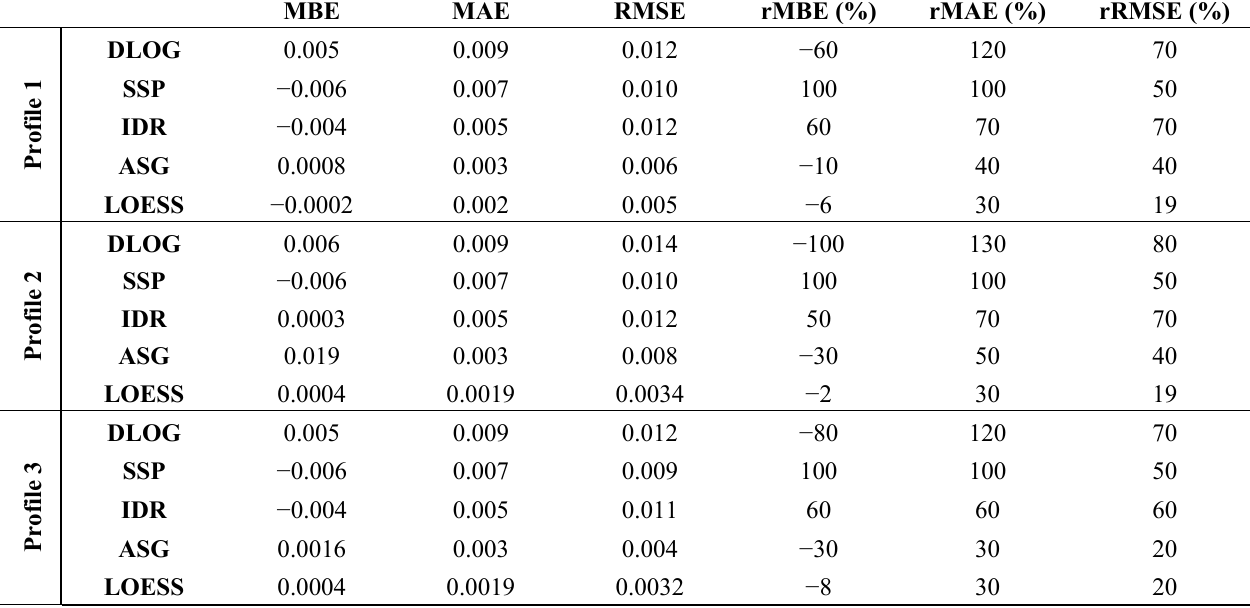
Table 5. Statistical results of the different filtering methods considered using extracted MODIS real gap